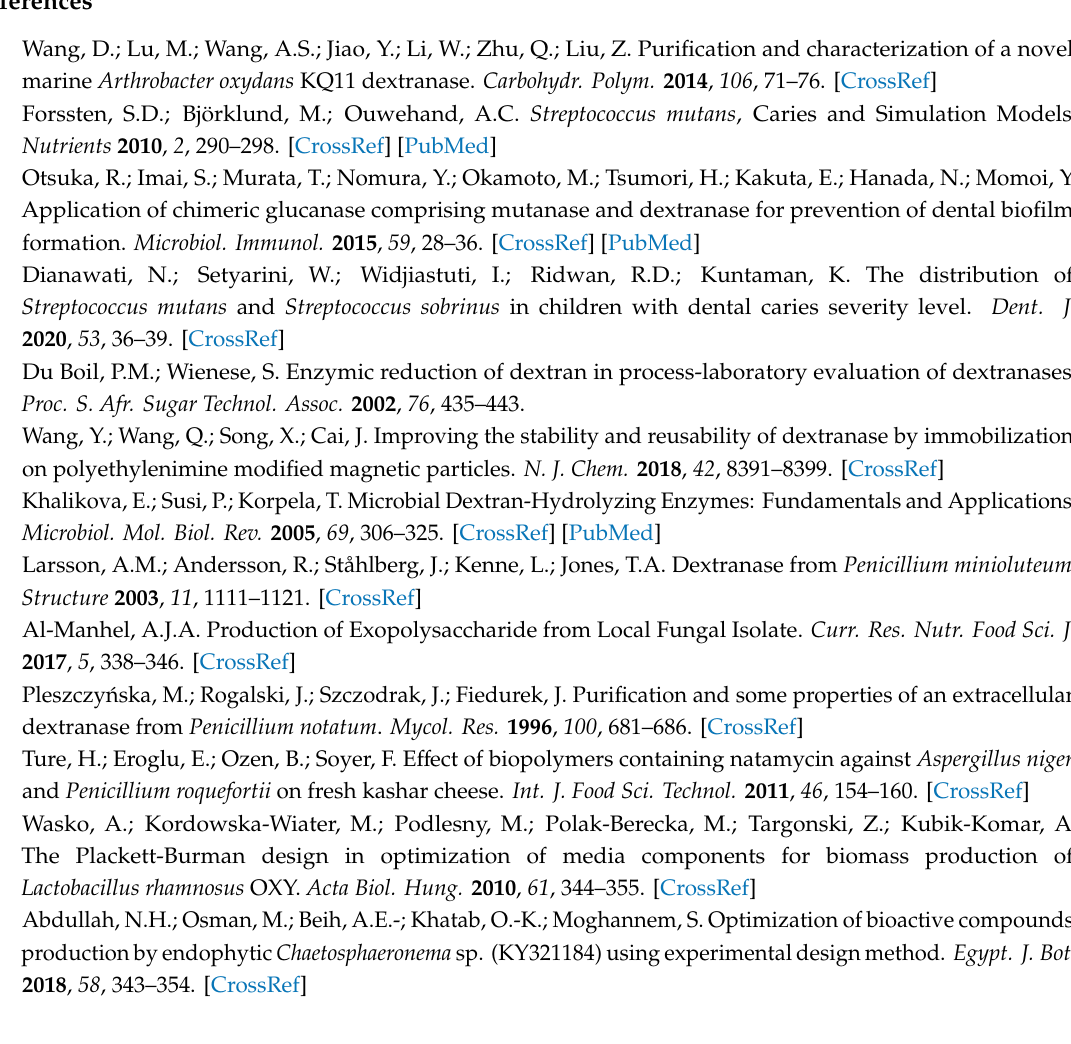
Figure A3. The e ff ect of crude dextranase from P. roquefortii TISTR 3511 on biofilm adherent capability Figure A3. The effect of crude dextranase from P . roquefortii TISTR 3511 on biofilm adherent capability of S. mutans ATCC 25175, comparison between negative control, positive control and crude ATCC 25175, comparison between negative control, positive control and crude of S . mutans dextranase .